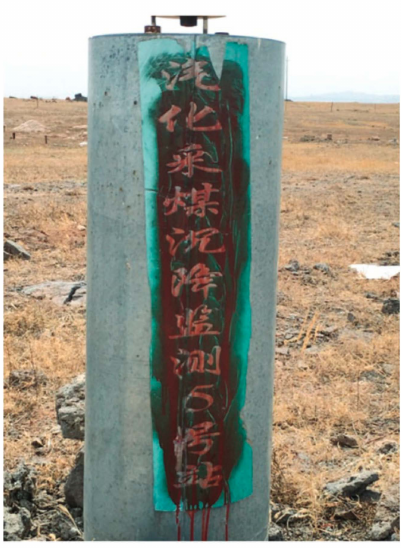
Figure 11. UCG surface subsidence No. 5 monitoring